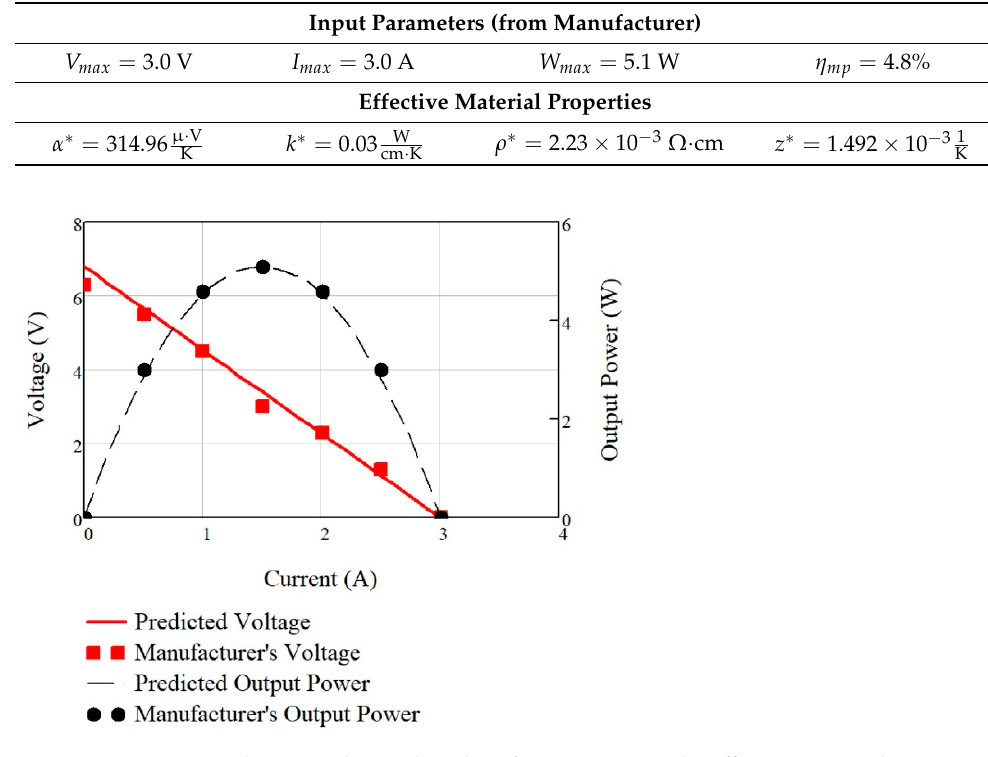
Figure 7. Comparison between the predicted performance using the effective material properties and the manufacturer’s performance. Table 1. The results of effective material properties for (TMG-127-1.0-0.8) at 𝑇 (cid:3035) = 200 ℃ , 𝑇 (cid:3030) = 30 ℃ , 𝑛 = 127, 𝐴 (cid:3032) = 1 mm (cid:2870) , and 𝐿 (cid:3032) = 1.35 mm .